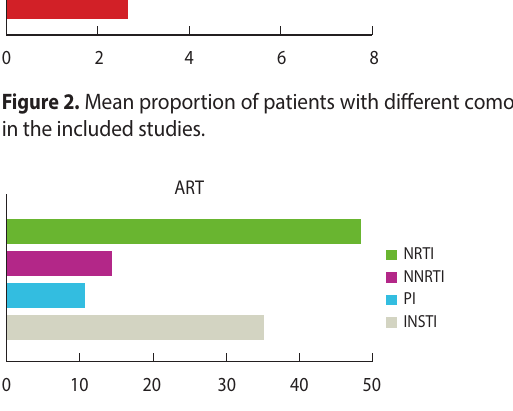
Figure 3. Mean proportion of patients receiving different antiret- roviral medications in the included studies. ART, antiretroviral therapy; NRTI, nucleoside reverse transcriptase inhibitor; NNRTI, non-nucleoside reverse transcriptase inhibitor; PI, protease inhibi- tor; INSTI, integrase strand transfer